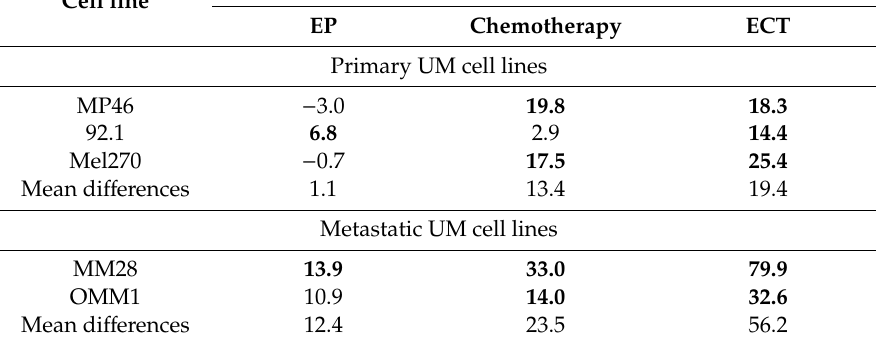
Table 1. Average di ff erences in spheroid growth of electroporation alone (EP), chemotherapy using bleomycin (2.5 µ g / mL) alone and electrochemotherapy (ECT) compared to untreated controls at day seven following treatment. Significant reduced cross-sectional areas ( p value ≤ 0.05) are highlighted in bold letters.